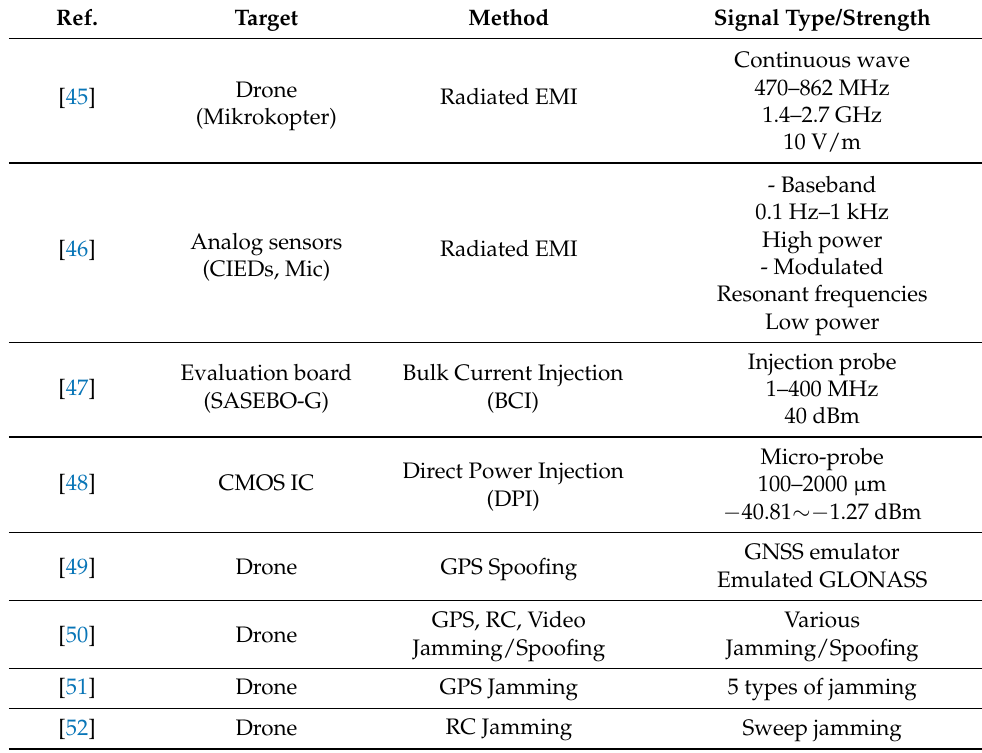
Table 3. Research on low power